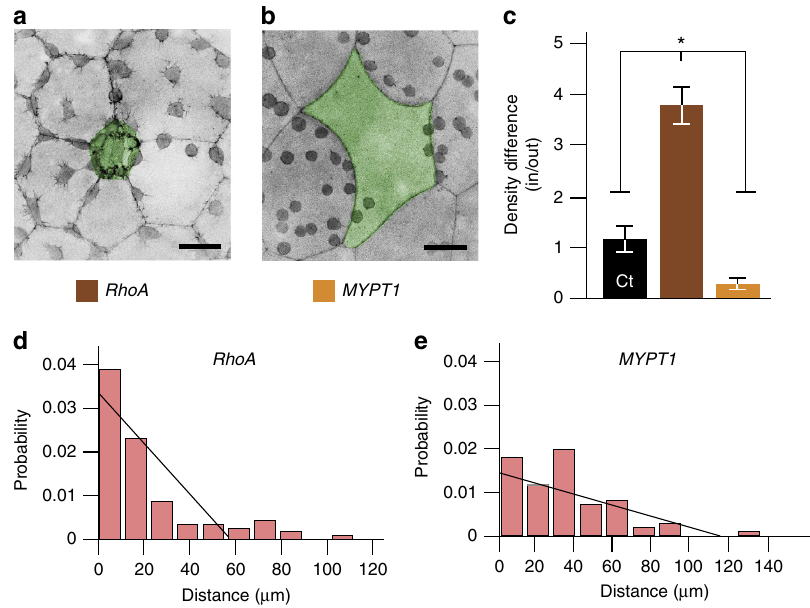
Figure 8 | Role of mechanical input from the extra-embryonic EVL in directing DCL spreading. ( a , b ) Confocal microscopy z -stack maximum projections with an inverted look-up table, showing a central EVL cell (pseudocoloured in green) overexpressing rhoA and N-ter-MYPT1 ( MYPT1 ). RhoA-mediated increase in cortical tension limits the surface expansion of the EVL cell and renders it smaller than neighbouring EVL cells ( a ). MYPT1-mediated decrease in cortical tension increases the surface expansion of the EVL cell rendering it larger and more concave, compared to neighbouring EVL cells ( b ). ( c – e ) Effect of the local modulation of EVL tension on the spatial distribution of DCL cells. ( c ) Quantification of the ratio of DCL cell density (number of DCL cells under the EVL per given area) between the injected EVL cell (‘In’; green cells in a and b ) and surrounding EVL cells (‘Out’). Values are expressed as means ± s.e.m., and correspond to control and injected conditions ( RhoA and MYPT1 , as indicated) ( n ¼ 3 embryos per condition). * P o 0.01 (Wilkoxon). ( d , e ) Probability distribution of DCL cell position as a function of the distance to EVL cell borders (measured from the DCL cell centre of mass to the closet EVL cell border) for the RhoA ( d ) and MYPT1 ( e ) conditions shown in a and b . The black straight lines corresponds to the expected random distributions